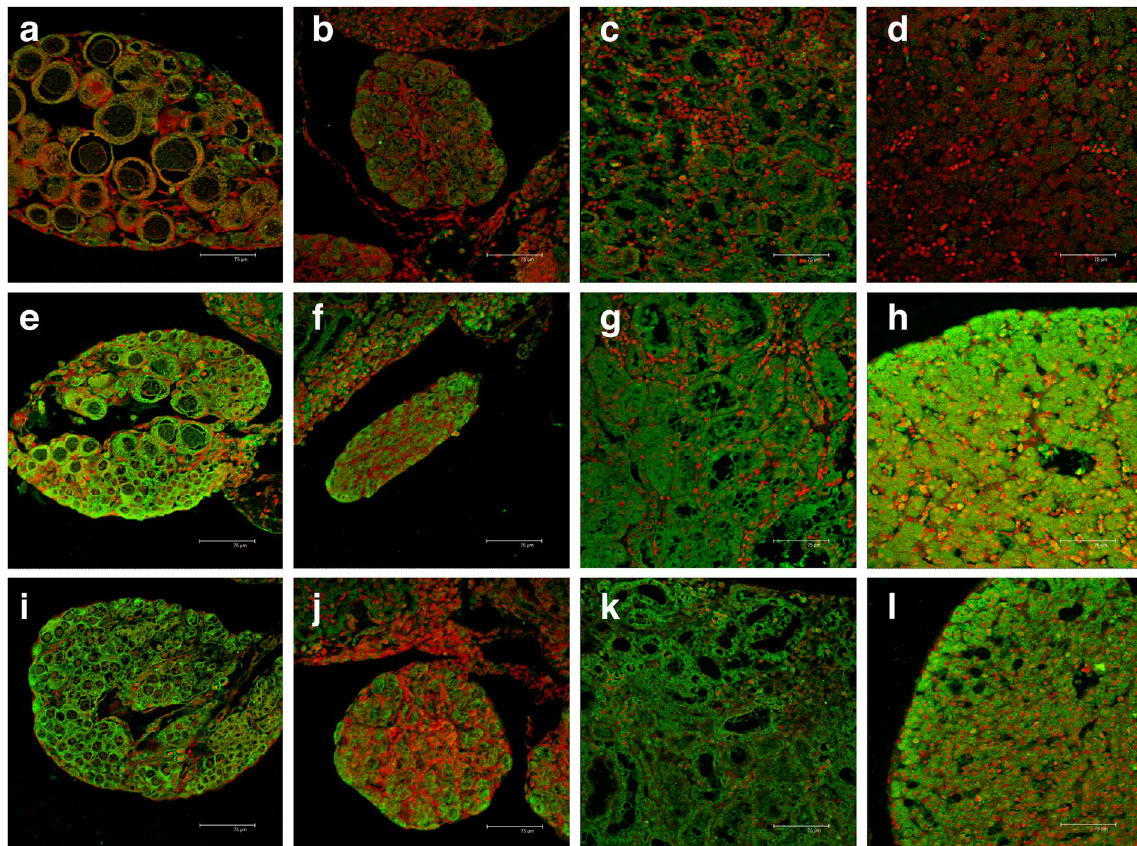
Figure 7. Immunolocalisation of caspase 3. Confocal micrograph of H . intermedia ovaries ( a , e , i ), testes ( b , f , j ), kidney ( c , g , k ) and liver ( d , h , l ) sections labeled with rabbit polyclonal antibody against caspase-3 (green – FITC labeled); nuclei are labeled with propidium iodide (red). ( a – d ) In control specimens no or extremely weak immunoreaction could be revealed. ( e – l ) After exposure to both pyrimethanil concentrations, it was possible to note a marked increase in caspase-3 immunoreactivity in samples from both low ( e – h ) and high ( i – l ) concentration